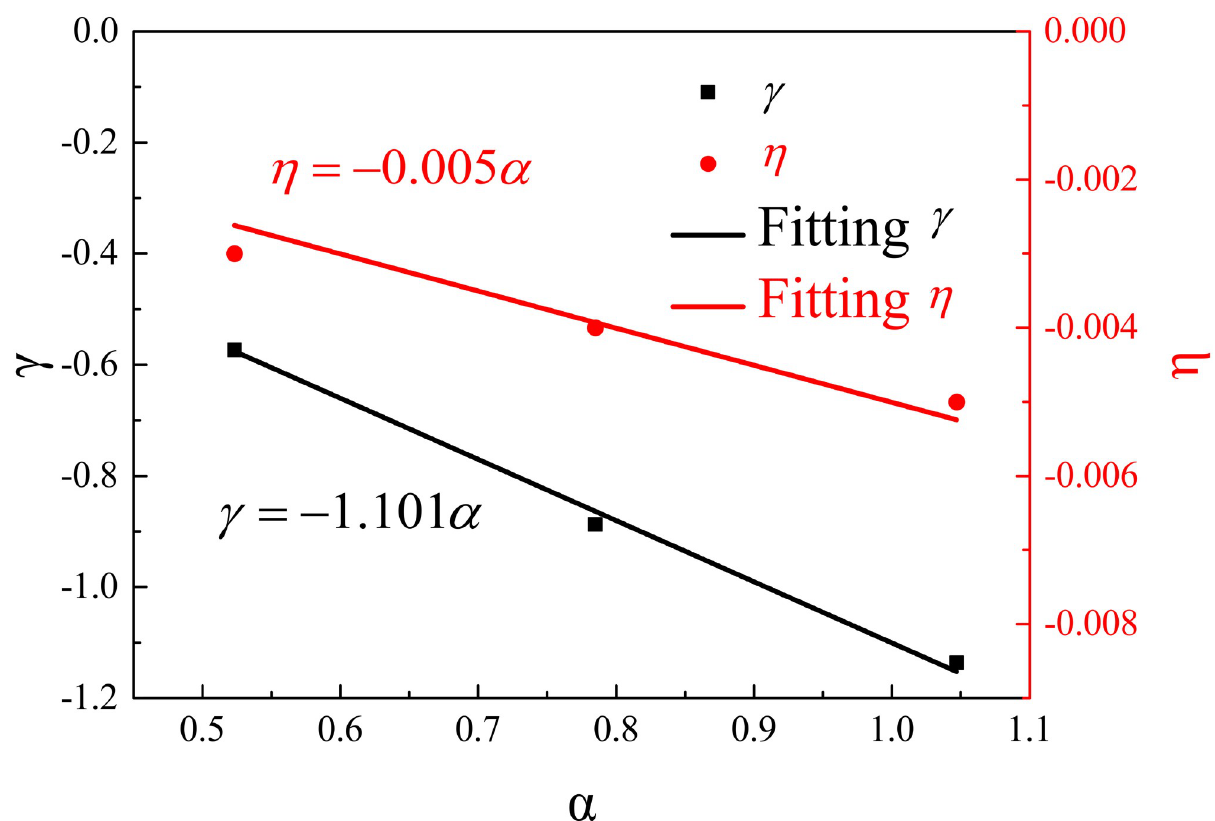
Fig 12. Fitting coefficients of γ and η against bifurcation angle.